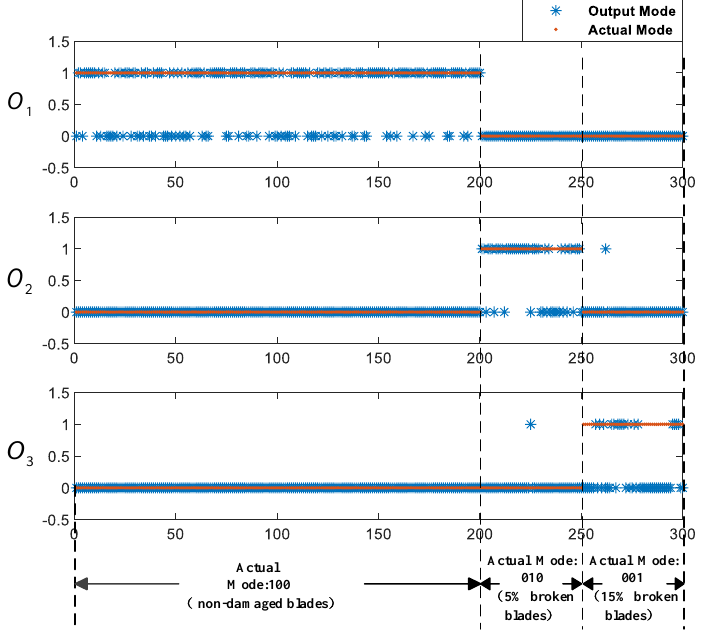
Figure 9. FDI results of the BP-based FDI